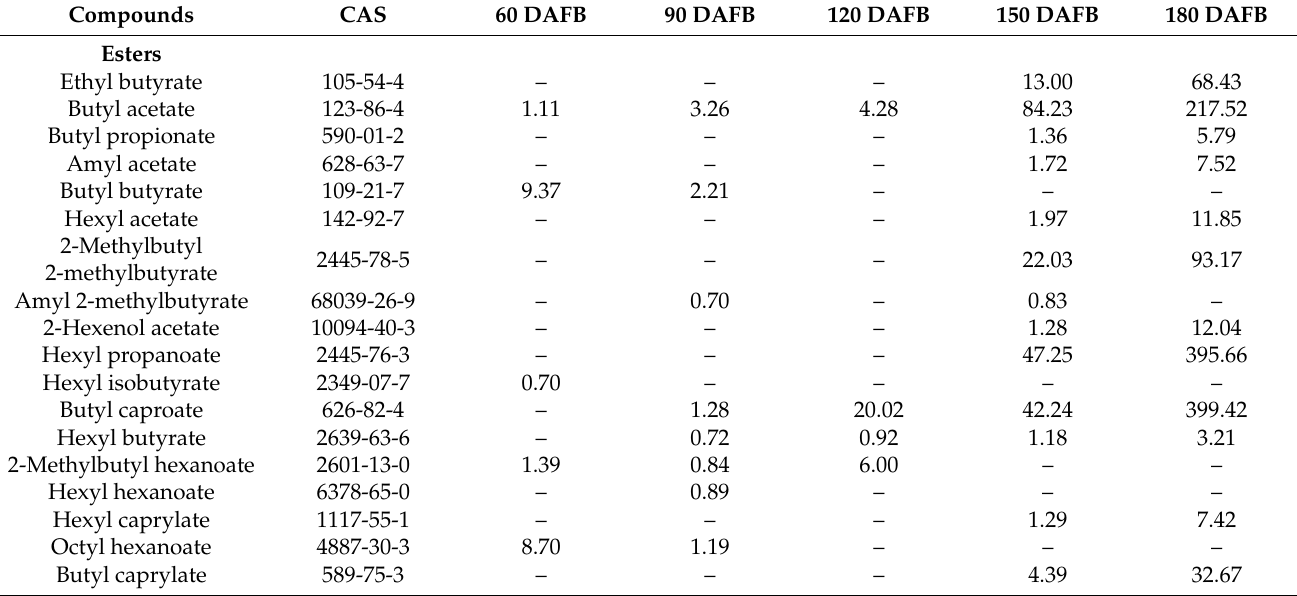
Table 5. The content ( µ g/kg FW) of volatile compounds in ‘Orin’ apple pulps at different ripening